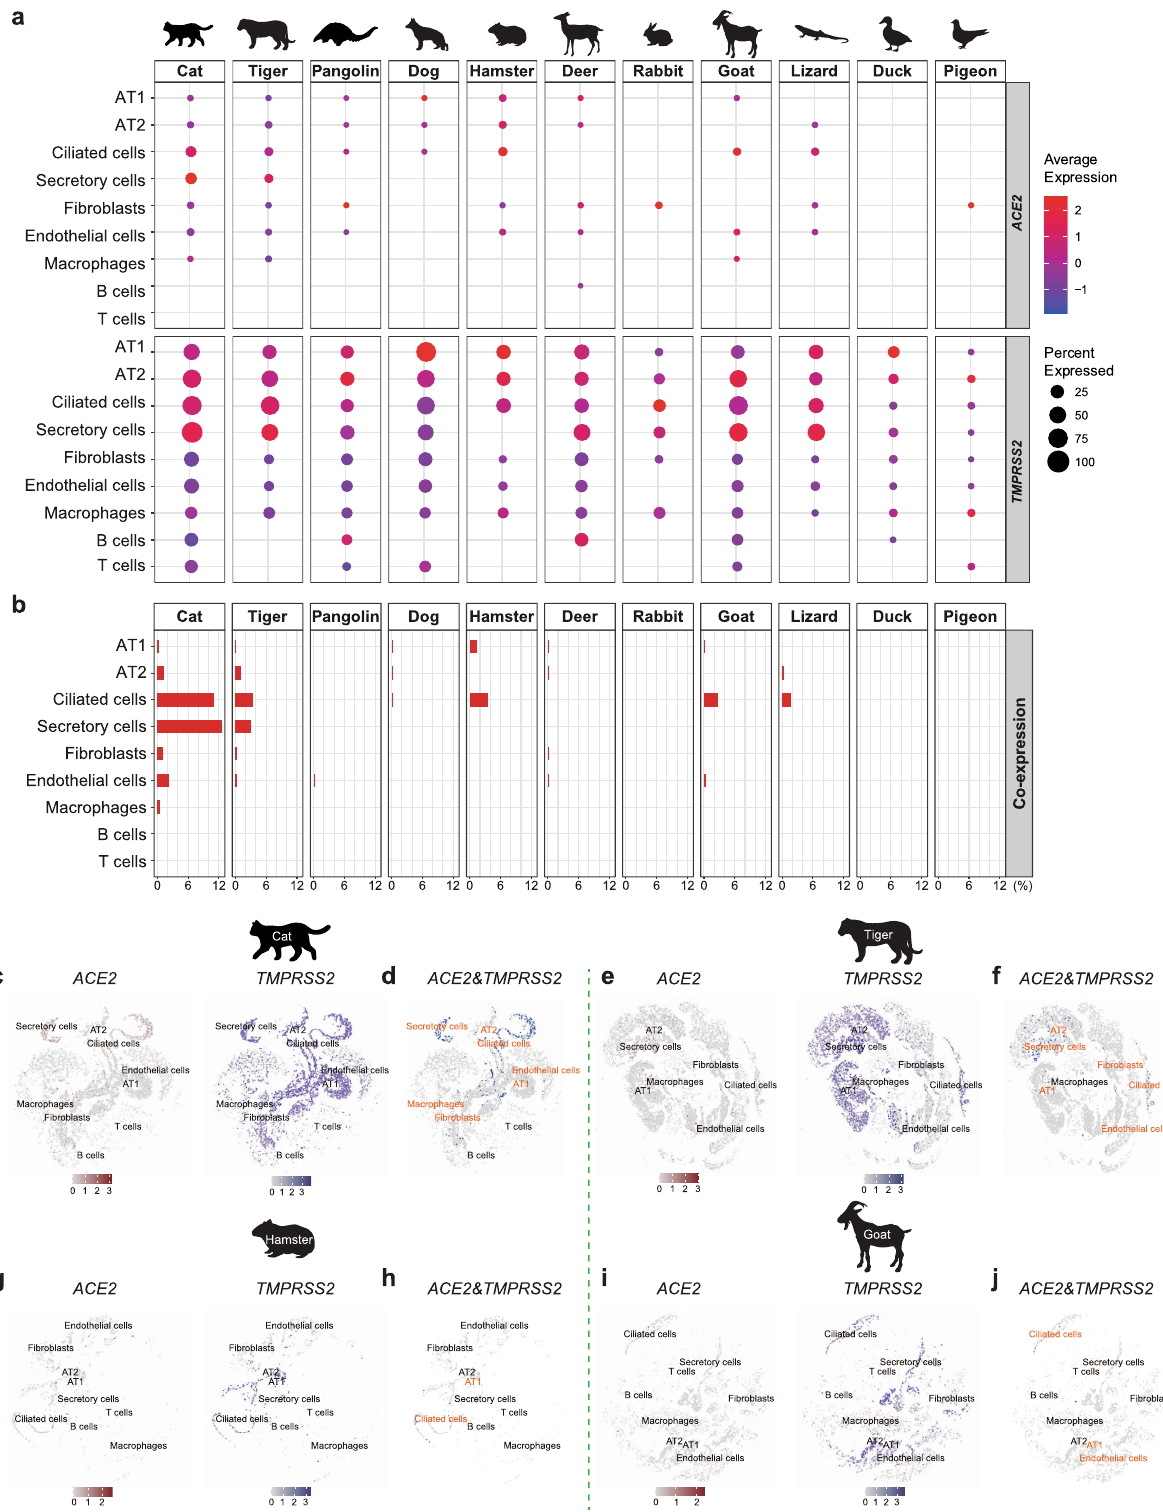
Fig. 3 Expression of ACE2 and TMPRSS2 in lung cells of wildlife, pets, livestock, and poultry. a Dot plot showing expression level and percentage of ACE2 and TMPRSS2 (indicated on the right) in each cell type (indicated on the left) of lungs across a variety of species (indicated above). Dot color represents scaled average expression level and dot size represent percentage of cells that expressed indicated gene within each cell type. b Bar plot showing percentage of cells that co-expressed ACE2 and TMPRSS2 within each cell type (indicated on the left) of different species (indicated above). c , e , g , i Feature plot showing the expression pattern of ACE2 and TMPRSS2 , respectively, in indicated cell types in lung of cat ( c ), tiger ( e ), hamster ( g ), and goat ( i ). d , f , h , j Feature plot showing the co-expression of ACE2 and TMPRSS2 in indicated cell types in lung of cat ( d ), tiger ( f ), hamster ( h ), and goat ( j ). Putative SARS-CoV-2 target cells were highlighted with red-colored